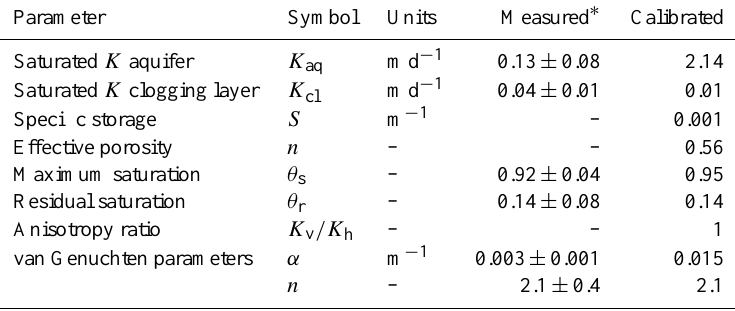
Table 1. Model parameters measured and calibrated using FePEST. Parameter